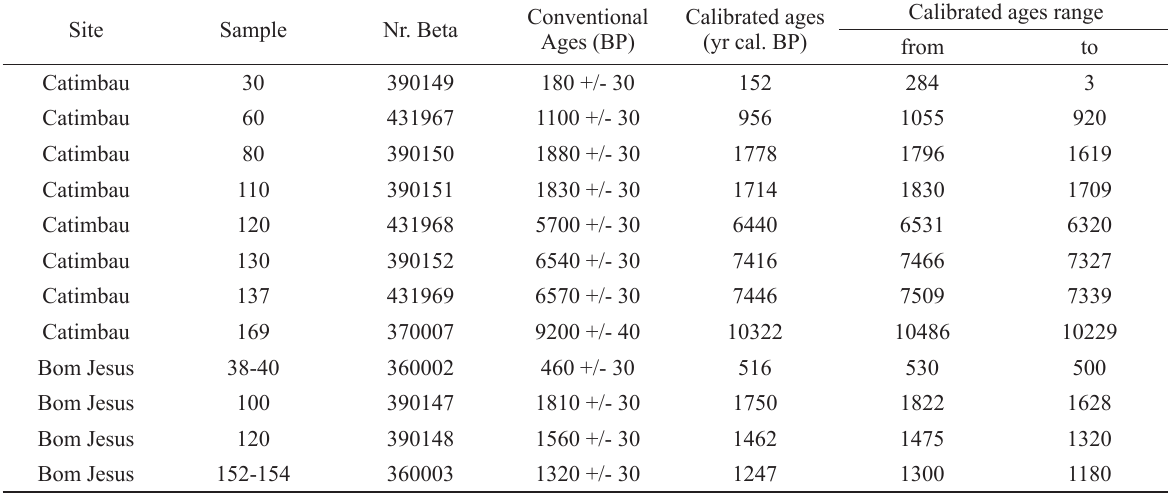
Radiocarbon ages for the Catimbau and Bom Jesus samples. Calibrations were calculated by software CALIB 7.1 (Stuiver et al. 2017), ranges of 95,4% (2ᵟ). Final calibrated ages were obtained from the median probability provided of the end